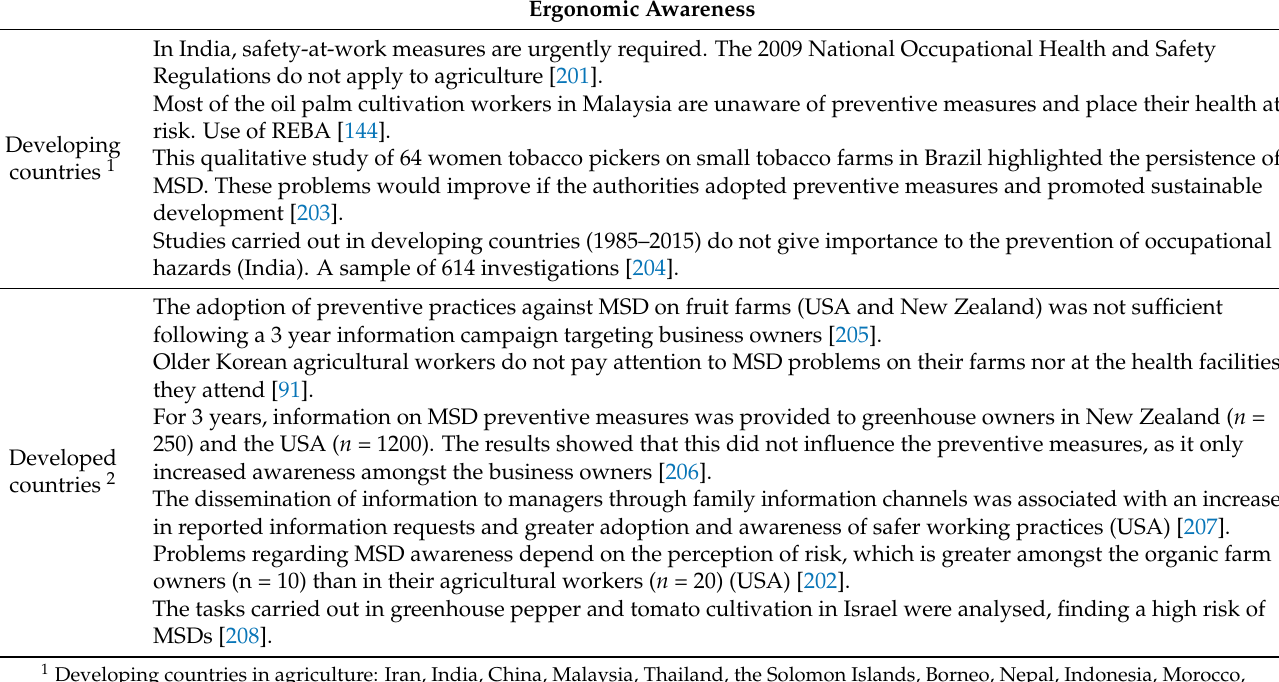
Table A13. MSD research in agriculture (1995–2020). Category: Ergonomic awareness. Ergonomic